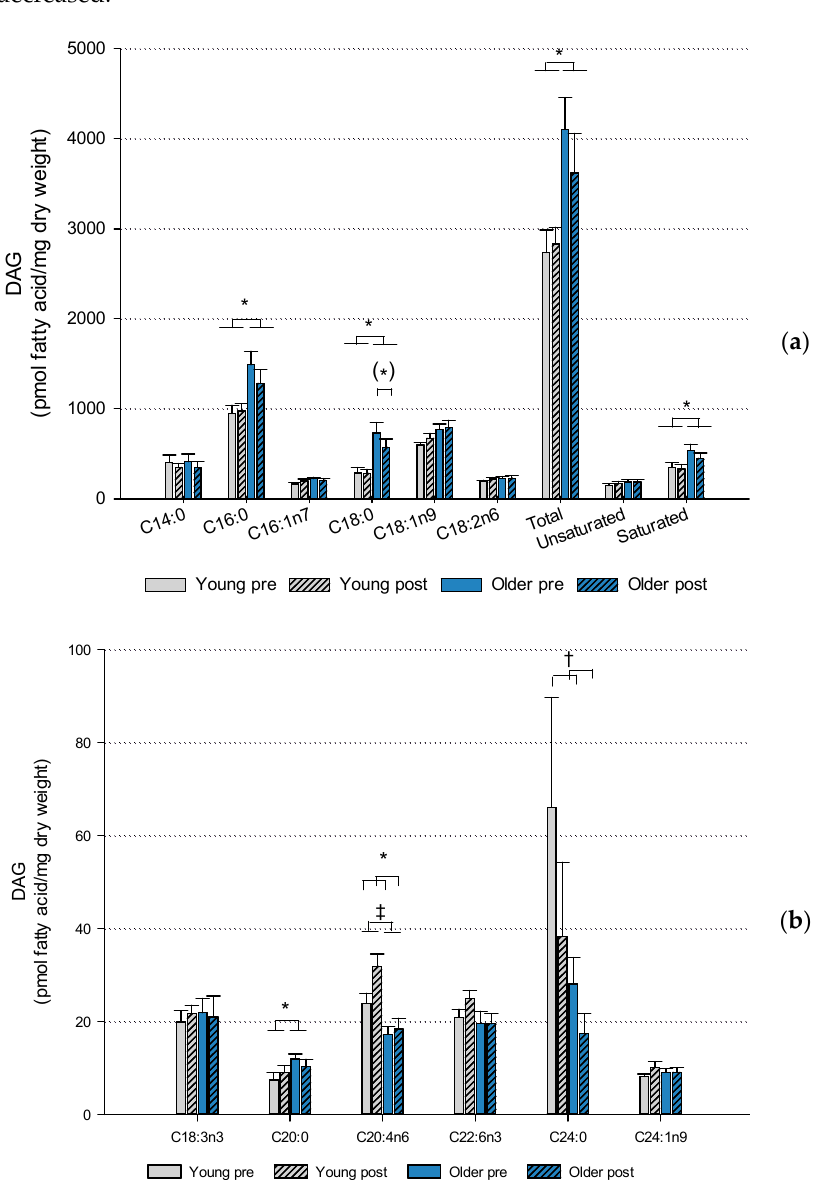
Figure 2. Diacylglycerol content. Bar charts illustrating the content of total and specific diacylglycerol fatty acids measured in muscle of young and older subjects before and after 6 weeks high-intensity interval training. ( a ) diacylglycerol fatty acids of high abundance and ( b ) diacylglycerol fatty acids of low abundance. Age and training effects: * p < 0.05, † p < 0.01, ‡ p < 0.001. Borderline significance: (*) p < 0.1. Young: n = 12, older: n = 21. Data are means ± SEM.